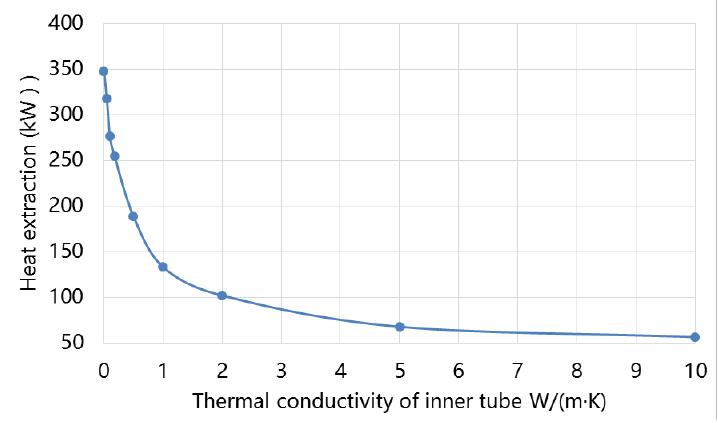
Figure 19. Effect of thermal conductivity of inner pipe on the heat extraction of DBHEs.